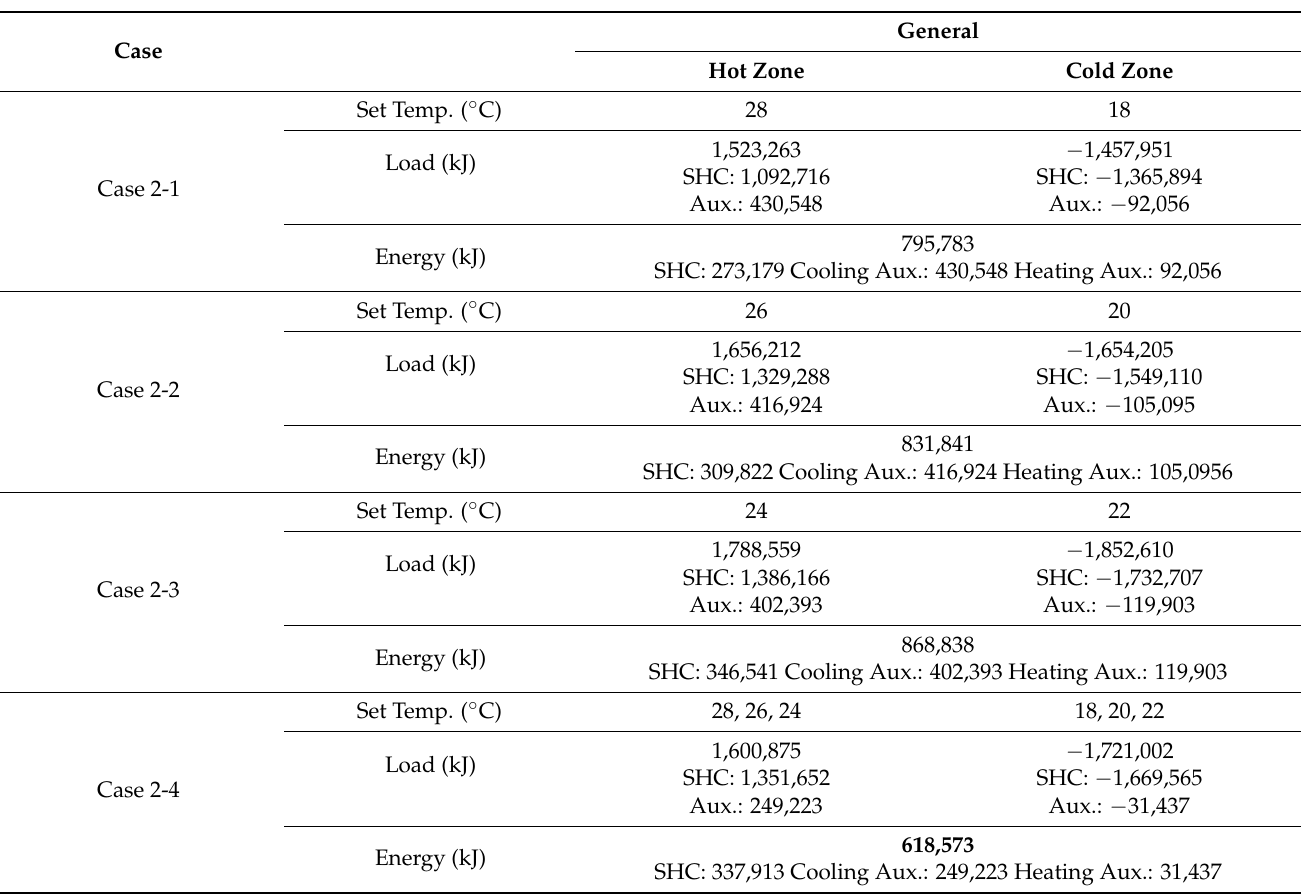
Table 9. Removed load and energy consumption (Cases 2-1~2-4).